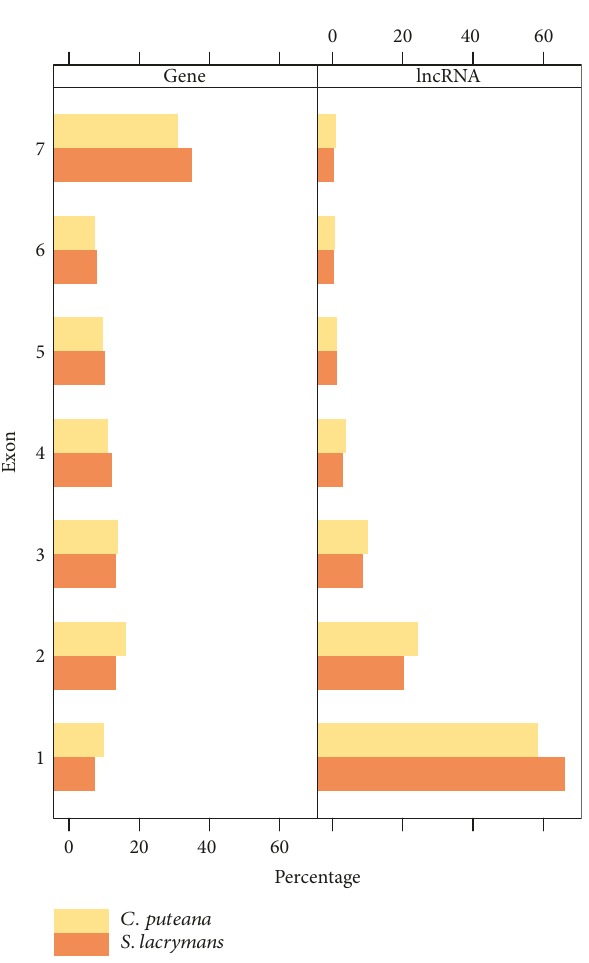
Figure 3: Exon number of lncRNAs and coding isoforms in C. puteana (orange) and S. lacrymans